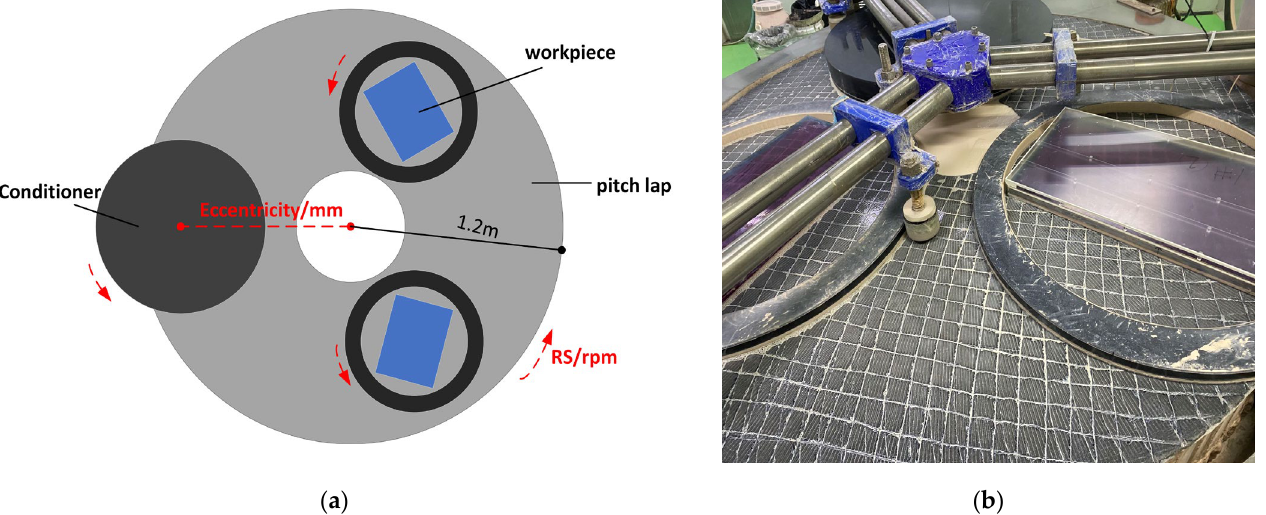
Figure 1. ( a ) General structure of the continuous polishing machine; ( b ) physical picture of the continuous polishing machine.